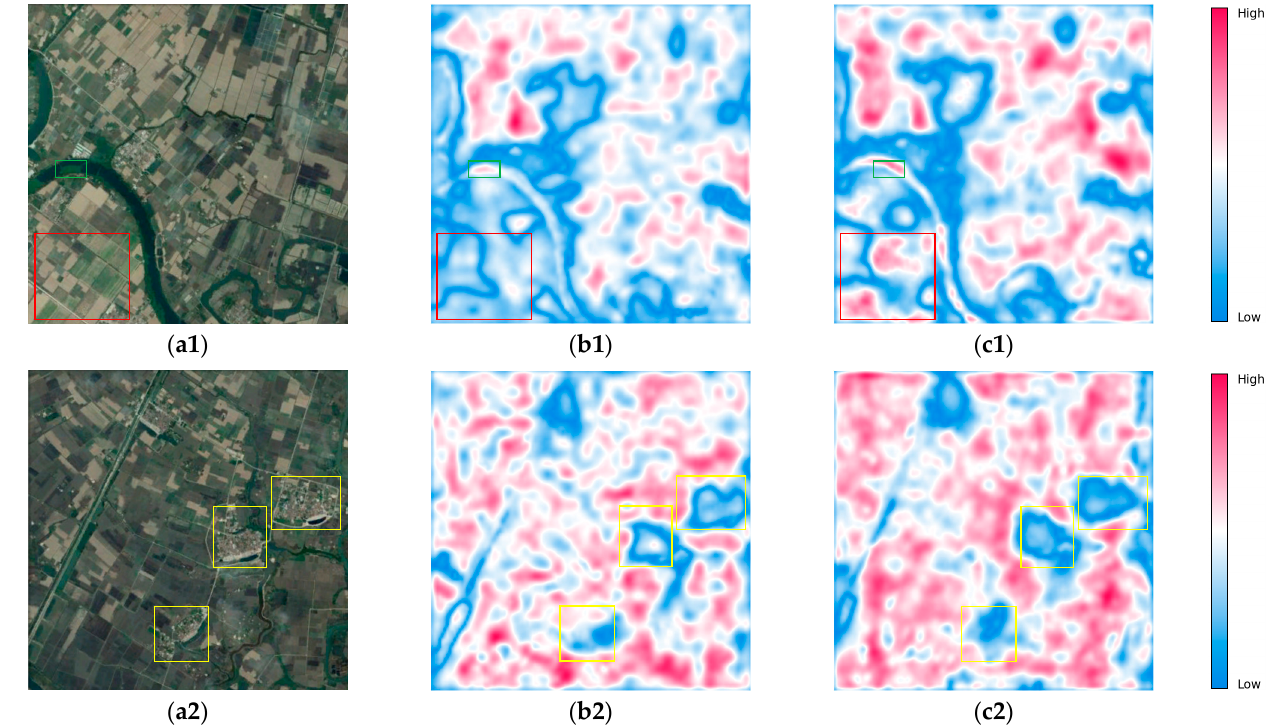
Figure 7. Comparison of the interlayer characteristics of SGEN without and with SSCM: ( a1 , a2 ) are the optical images (13 March 2018) of different rice regions, respectively; ( b1 , b2 ) are the interlayer characteristics of SGEN without SSCM; ( c1 , c2 ) are the interlayer characteristics of SGEN with SSCM. The red, green, and yellow borders indicate the rice area, non ‐ rice area, and building area, respectively.